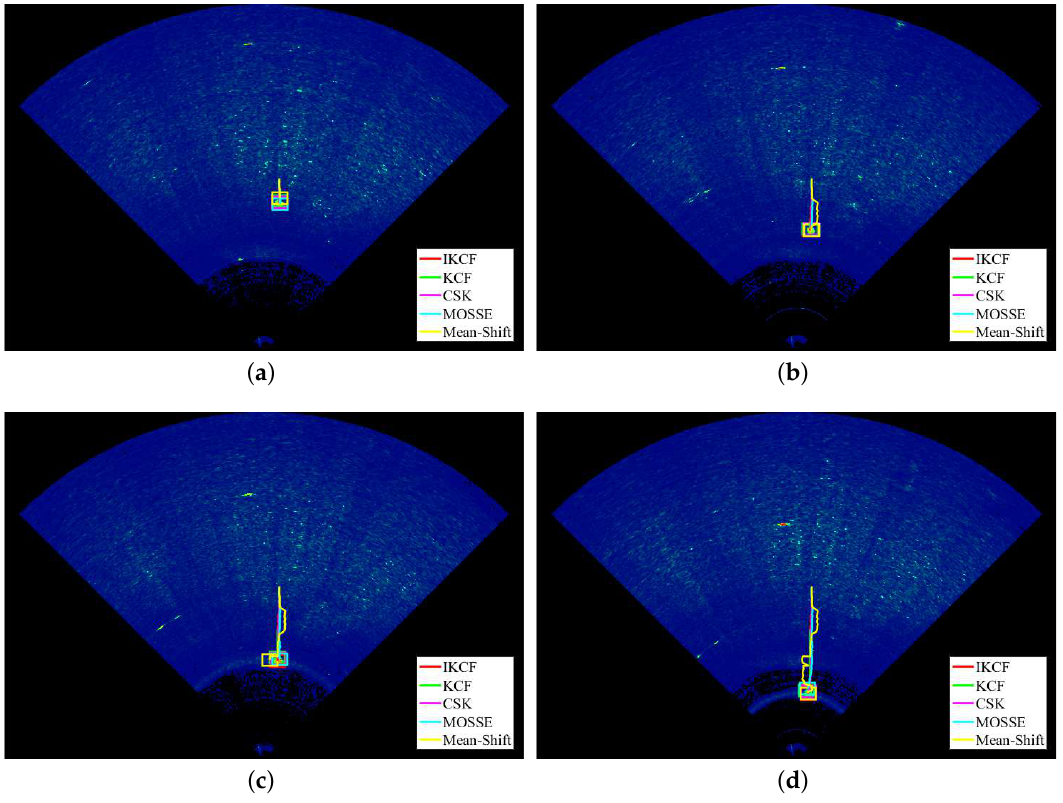
Figure 4. Tracking results for normal target: ( a ) The tracking results at the 12th frame; ( b ) the tracking results at the 25th frame; ( c ) the tracking results at the 35th frame; ( d ) the tracking results at the 51st frame.